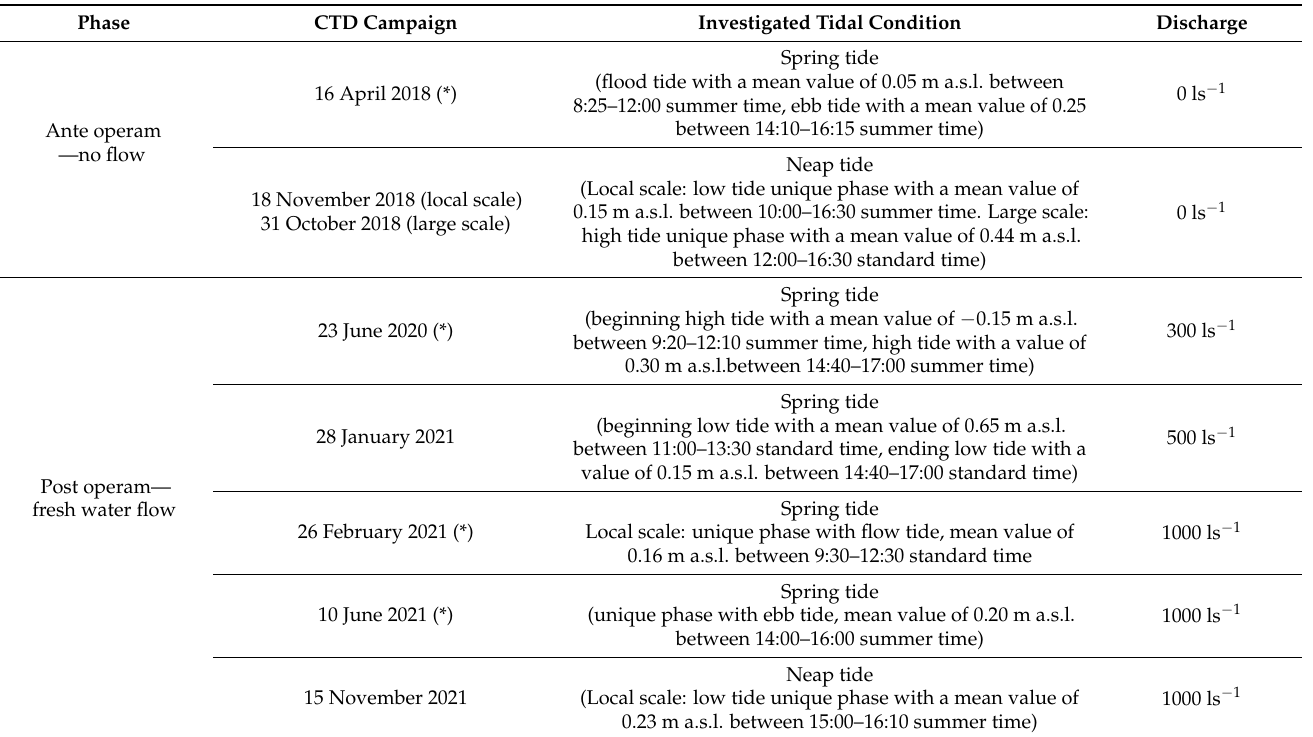
Table 1. CTD campaigns before and after the opening of the fresh water flow. Mean tide values are evaluated according to the nearest ISPRA’s meteo-mareographic station located in Grassab ò area. Values of tidal level are referred to m a.s.l. and they are averaged values within each timewindow. (*) Campaigns considered for this